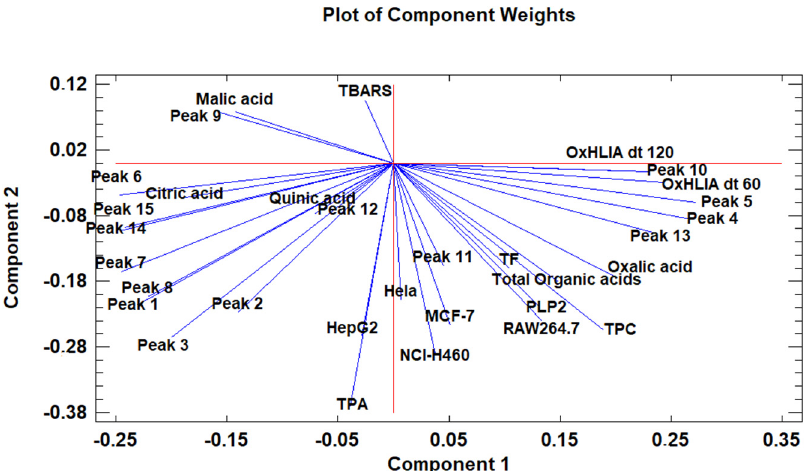
Figure 4. The principal component loading plot of the tested variables at different maturation stages of cardoon petioles.